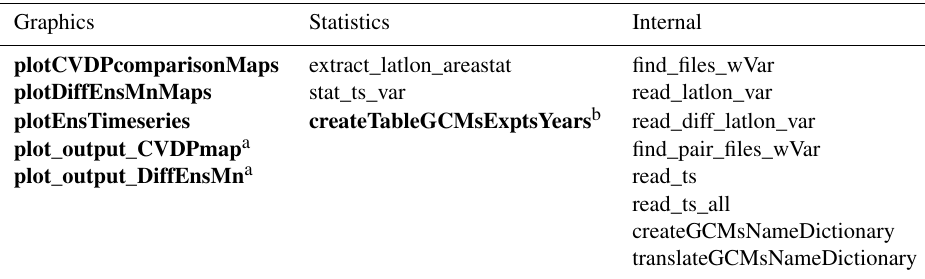
Table 2. The NCL functions and procedures created to support analyses of the CVDP summary files. They are categorised according to whether they return a graphic or a statistic or produce no output at all to the user and are intended to be called internally. Bold font indicates a procedure; the rest are